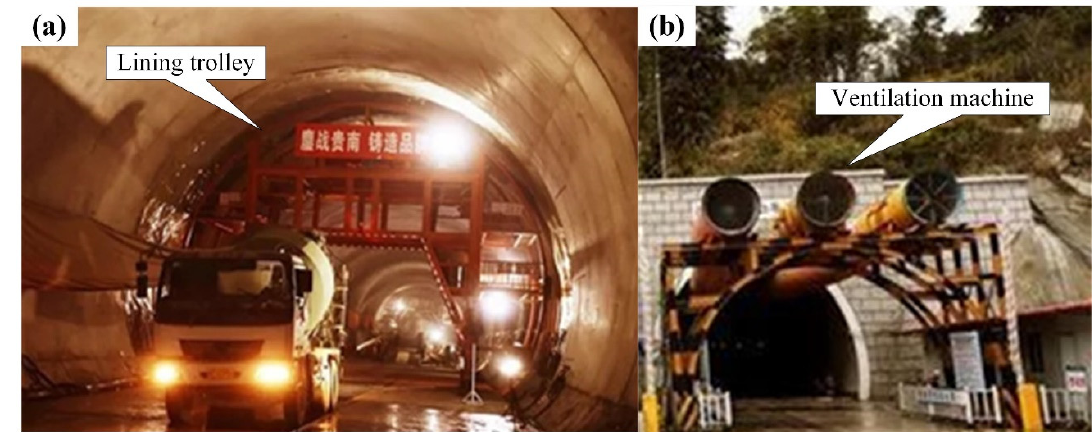
Figure 2. Construction situation ( a ) inside and ( b ) outside the tunnel before the incident.